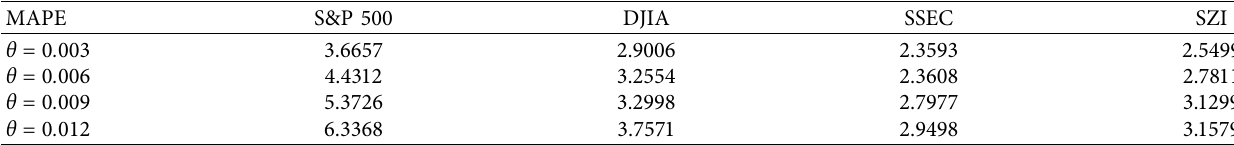
Table 4: Forecasting errors (MAPE) of the FM-Elman ( k � 3) model as threshold value θ varies.